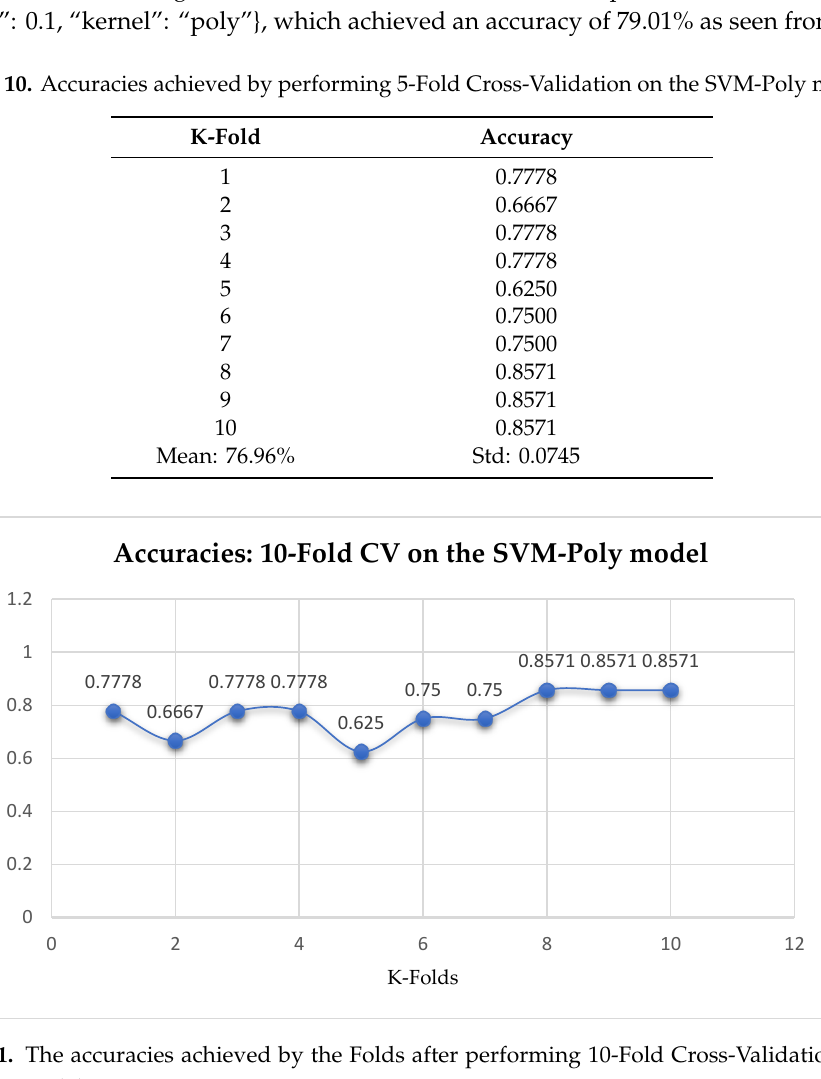
Table 10. Accuracies achieved by performing 5-Fold Cross-Validation on the SVM-Poly model.